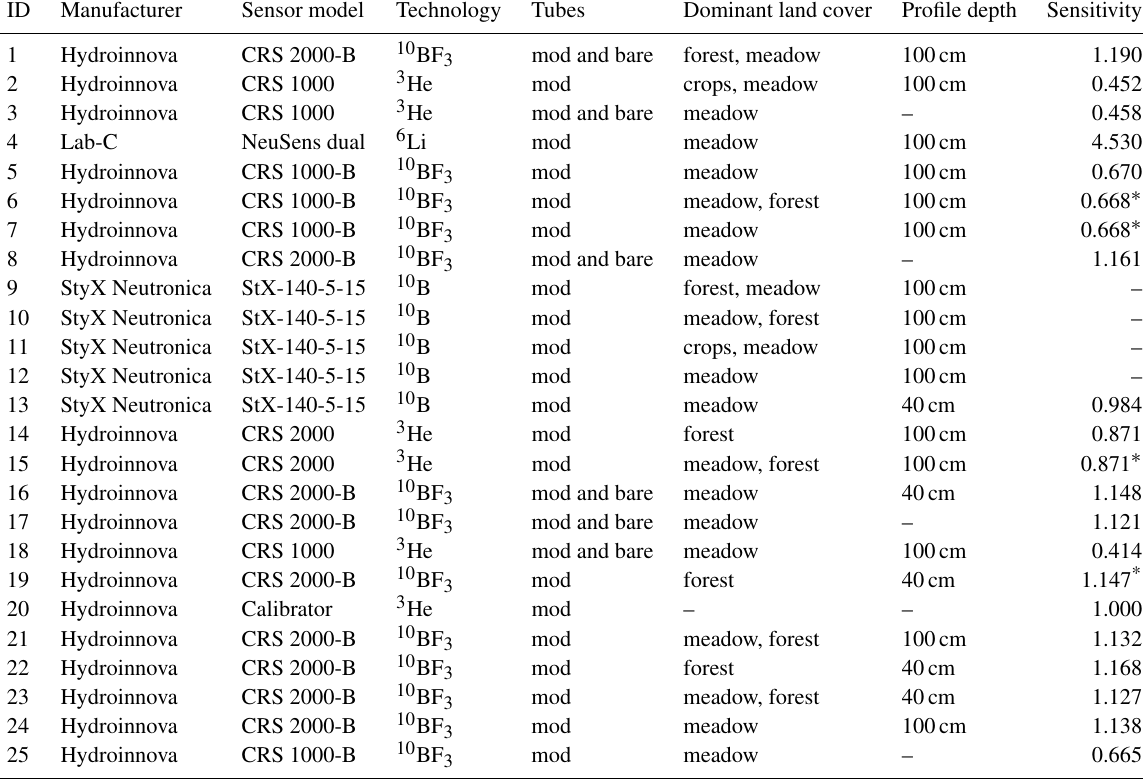
Table 2. Overview of CRNS sensors installed during the JFC, including manufacturer, model, and converter technology; the availability of standard moderated detector tubes for epithermal neutrons (mod) and additional bare tubes for thermal neutron detection (bare); the dominant land cover in the footprint of the sensor; the maximum measurement depth of colocated profile probes near the CRNS sensor; and the sensitivity factor (ratio between raw neutron counts of the individual sensor and the calibrator unit no. 20).